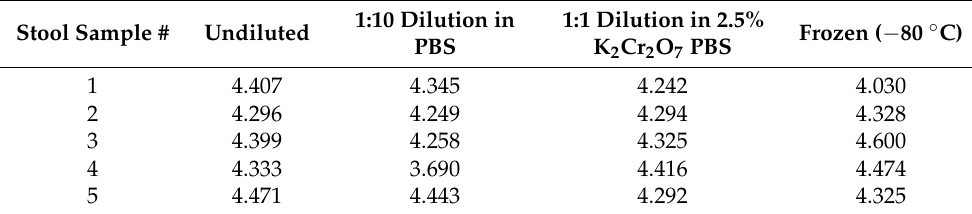
Table 1. Influence of PBS dilution, K 2 Cr 2 O 7 addition and freezing of Cryptosporidium oocyst-positive samples on ELISA optical density (OD)